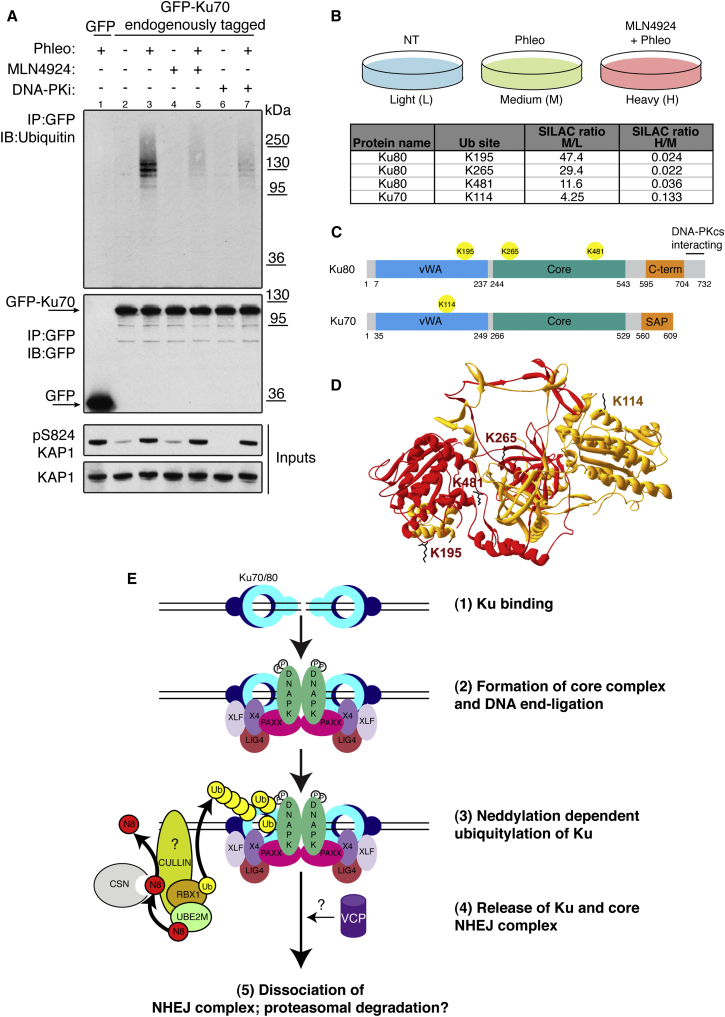
MLN4924 Blocks Ku Ubiquitylation after DNA Damage(A) In vivo ubiquitylation assay. RPE-1 cells expressing Ku70 endogenously tagged with GFP (lanes 2–7) or RPE-1 cells stably expressing GFP (lane 1) were pre-treated with DMSO, 3 μM MLN4924, or 3 μM DNA-PK inhibitor for 1 hr prior to treatment with 500 μM phleomycin (Phleo) for 1 hr as indicated. Cell lysates were immunoprecipitated (IP) with GFP-specific antibody and immunoblotted (IB) with indicated antibodies. GFP-Ku70 IP was done under stringent conditions (see Experimental Procedures). Black arrows indicate GFP-Ku70 and GFP. Phosphorylated Ser824 of KAP1 is used as a DNA-damage marker.(B) Identification of Ku ubiquitylation sites by quantitative LC-MS/MS. RPE-1 cells stably expressing Ku70 endogenously tagged with GFP were labeled with light, medium, or heavy SILAC isotopes and treated as indicated. Ku70 was enriched with GFP-Trap agarose under stringent washing conditions. Enriched proteins were resolved by SDS-PAGE and proteolysed in gel with trypsin. Peptides were extracted from gel and analyzed by LC-MS/MS. SILAC ratio M/L >2 represents induction upon DNA damage; SILAC ratio H/M < 0.5 represents inhibition by MLN4924 (see also Table S2).(C) Schematic representation of Ku70 and Ku80 domains with neddylation-dependent ubiquitylation sites identified in (B). vWA, von Willebrand factor A; C-term, C terminus; SAP, SAF-A/B, Acinus, and PIAS.(D) Positions of DNA-damage-induced neddylation-dependent ubiquitylation sites in the context of the structure of the Ku heterodimer (ID:1JEQ). Ku70 and Ku80 are in orange and red, respectively, and the ubiquitylated side chains are in black.(E) Model. (1, 2) Ku and the NHEJ complex are recruited to sites of DSBs. (3) Neddylation-dependent ubiquitylation of Ku following completion of DNA repair. (4) Ku and NHEJ factors are released from sites of DNA damage. VCP might target ubiquitylated Ku to proteasome for degradation. N8, NEDD8; Ub, ubiquitin; P, phosphorylation (see text for details). See also Figure S4.